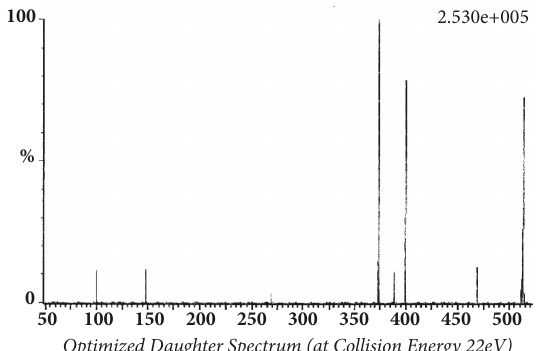
Figure 3: Transition of glibenclamide sodium adduct to daughter fragment (m/z 516.11 > 417).